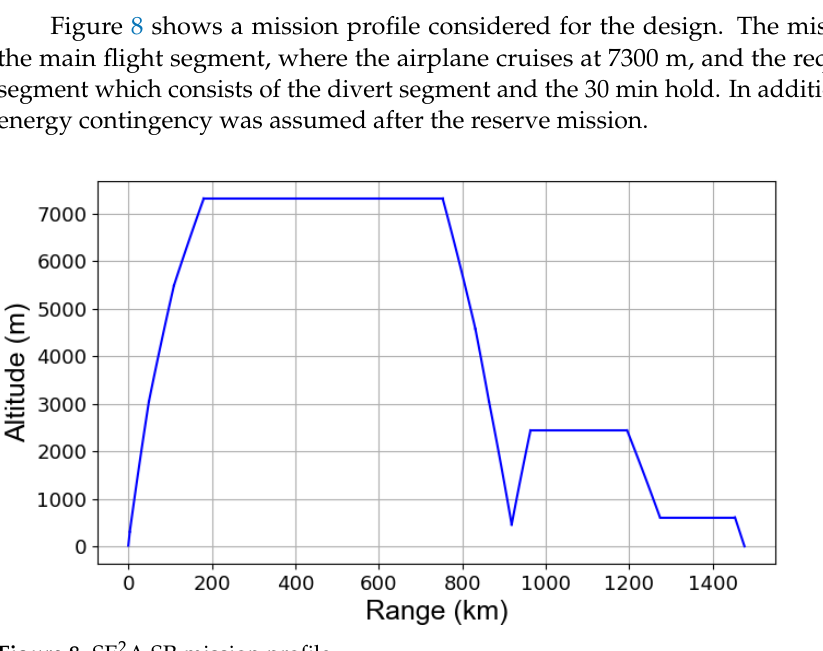
Figure 8. SE 2 A SR mission